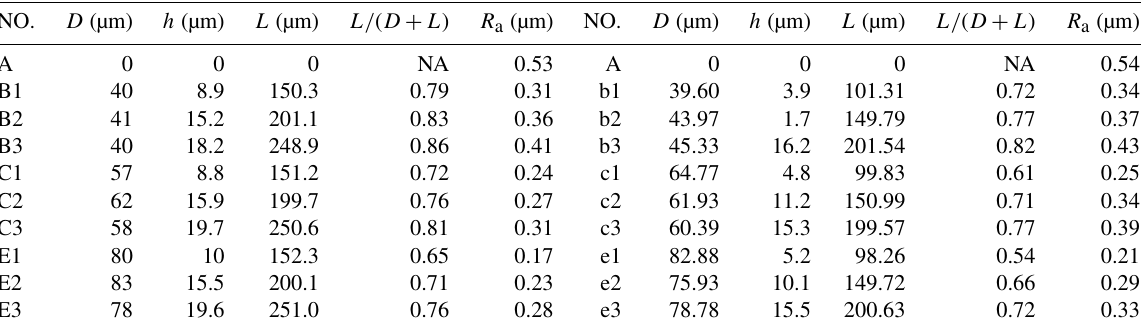
Table 2. Parameter of the normal and the tangential experimental specimen of the groove (A, B1, B2, B3, C1, C2, C3, E1, E2, E3) and the micro-pits (A, b1, b2, b3, c1, c2, c3, e1, e2,